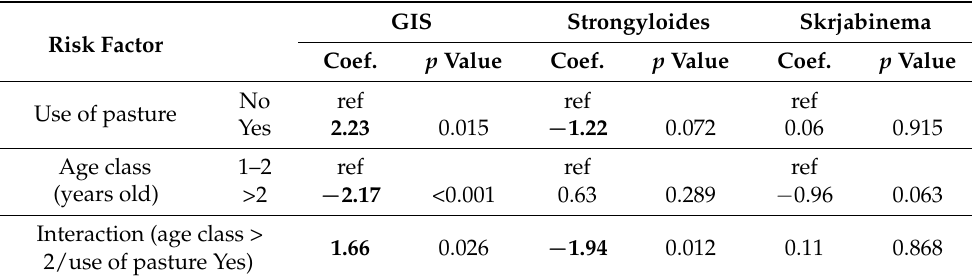
Table 4. Interaction between the two factors ‘use of pasture’ and ‘age class’ in negative binomial regression model for GIS, Strongyloides and Skrjabinema , considering only adult females (n = 231). Significant values are highlighted in bold.